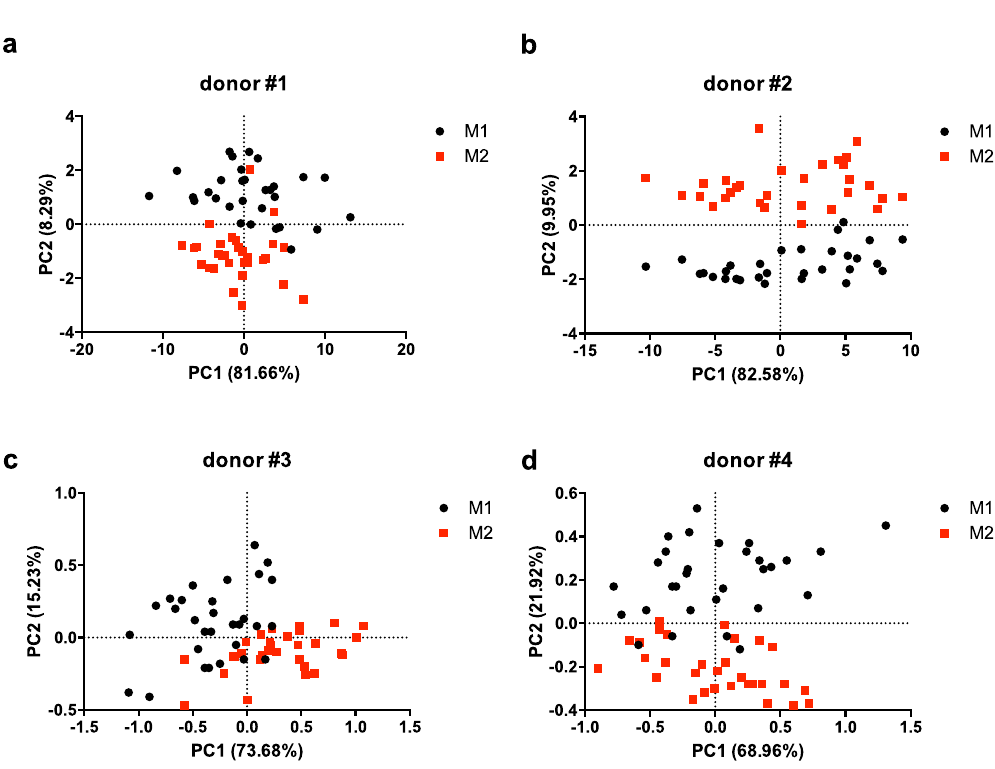
Figure 5. Principal Component Analysis. PCA score plots of MDM spectra for different donors. Spectra of M1 and M2 MDMs are represented as black circles and red squares,